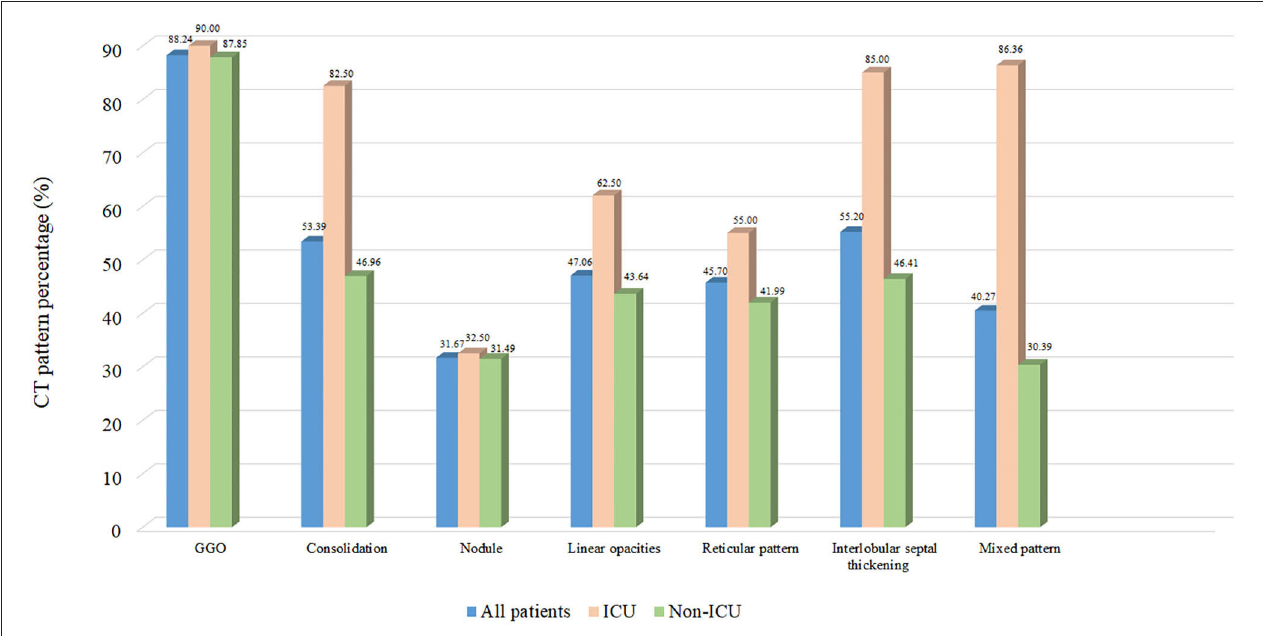
FIGURE 4 | Distribution of various patterns in COVID-19